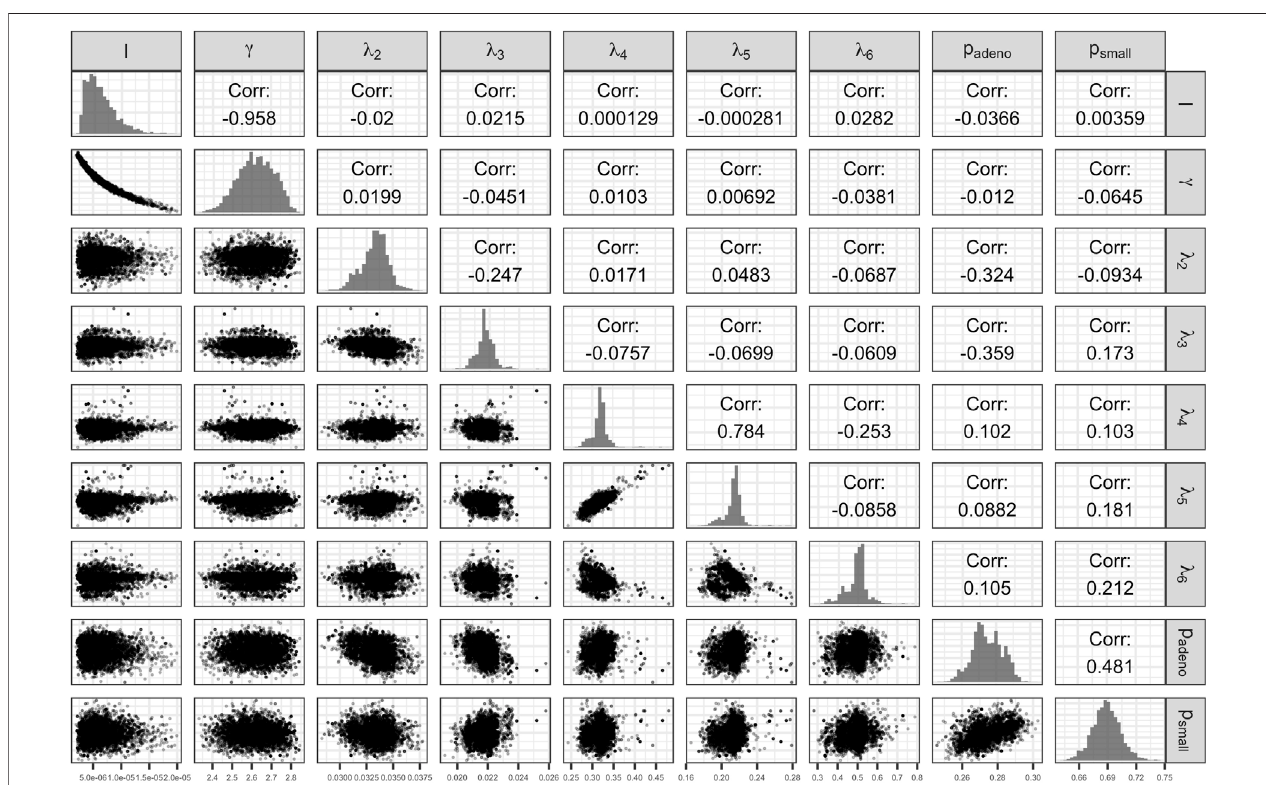
FIGURE 3 | Scatter plot of pairs of deep model parameters with correlation coef fi cient and posterior marginal distributions.